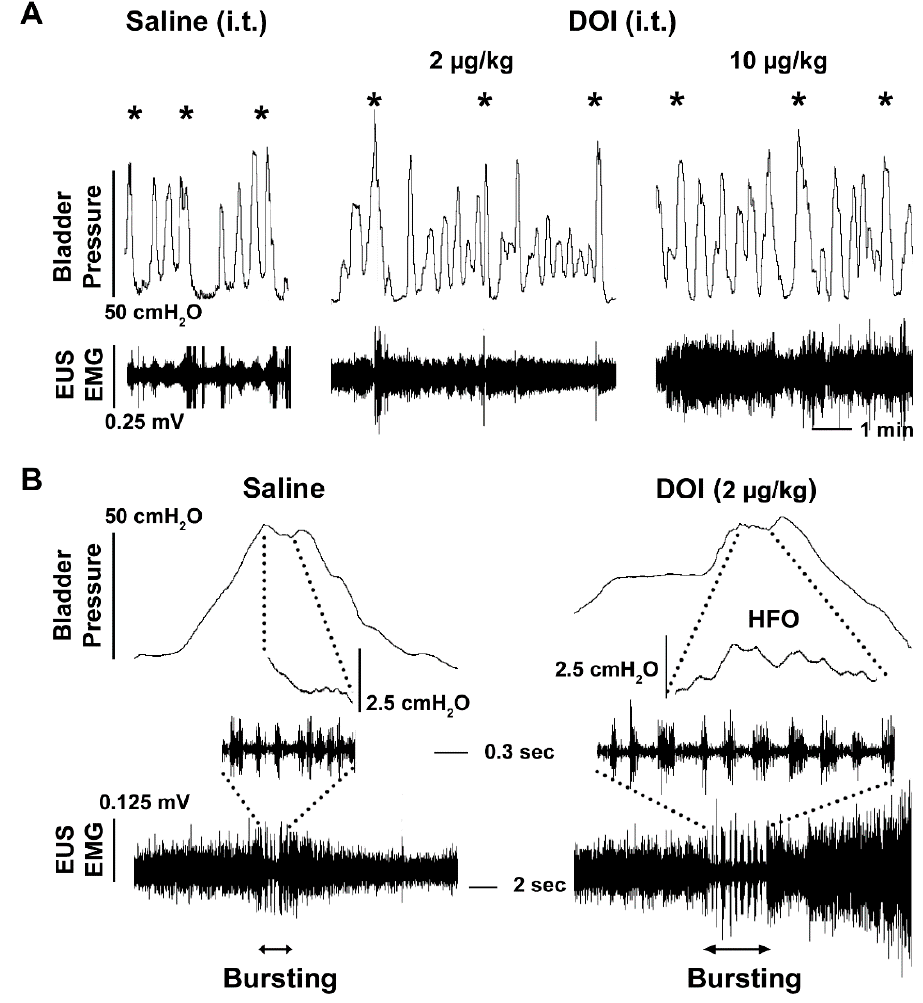
Figure 3. Intrathecal (i.t.) administration of DOI to stimulate 5-HT 2A receptors affects the micturition reflex during bladder cystometry and sphincter EMG in SCI rats. ( A ), Representative tracers show that stimulating 5-HT 2A receptors with the middle (2 µ g/kg) and high (10 µ g/kg) doses of DOI prolongs the VI (both p < 0.05, Friedman’s test followed by Dunn’s) between voiding contractions (asterisks) and induces an increase in EUS tonic activity. ( B ), Importantly, the middle dose of DOI increases the duration of EUS bursting that consists of more regularly occurring active and silent periods along with bladder HFO, indicating an enhancement of detrusor-sphincter coordination during voiding. Table 2. Normalized parameters of bladder cystometry and EUS EMG activity in SCI rats ( i.t. administration). Drugs